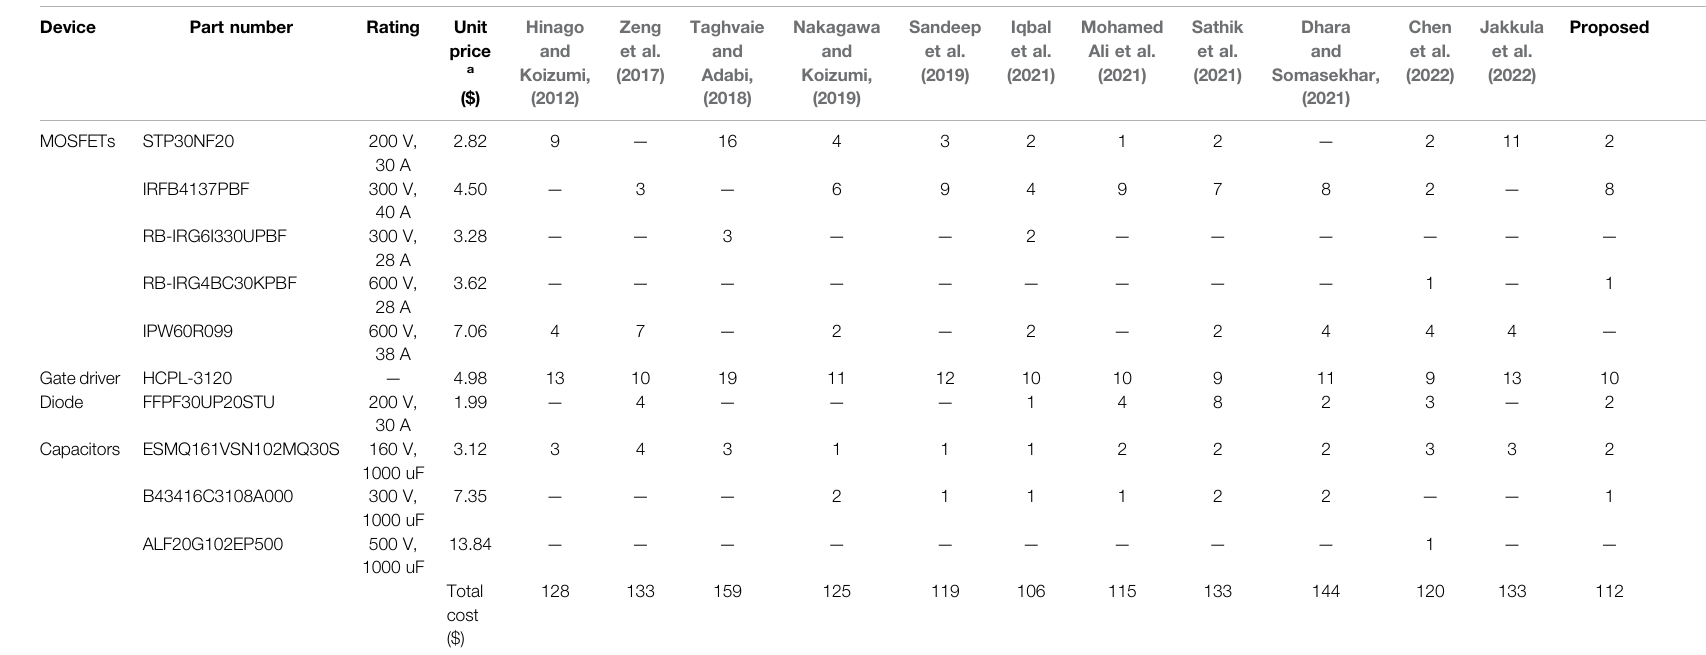
TABLE 3 | Cost comparison of the proposed topology with other recent topologies. Device